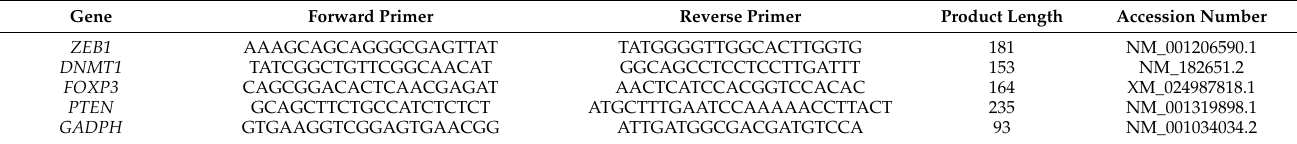
Table 2. Forward and reverse primer sequence for quantitative real-time polymerase chain reaction amplification of mRNA for canine testis